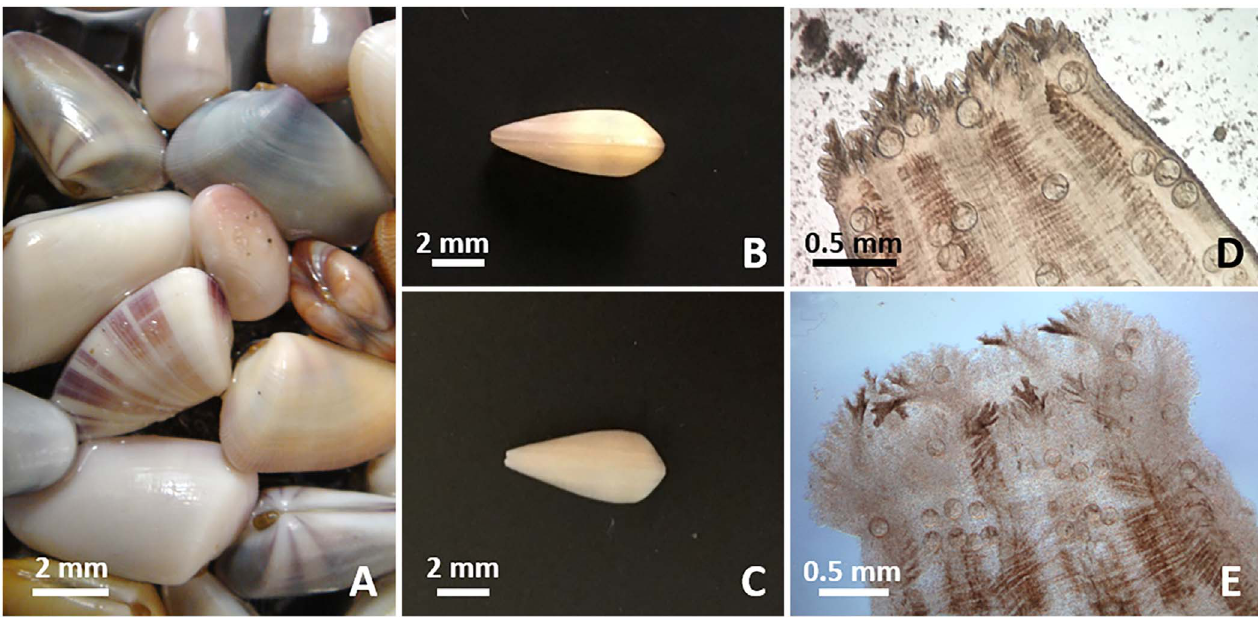
Figure 1. Donax spp. from the southeastern US Atlantic coast. (A) Coquinas showing shell color variation. (B – C) Ventral view of shell of D. variabilis (B) showing an elongated outline and thin anterior pedal region, and D. fossor (C) showing a more triangular outline compared to D. variabilis and a thick anterior edge. (D – E) Inhalant siphon of D. variabilis (D) showing smaller folds harboring smaller papillae than those of D. fossor